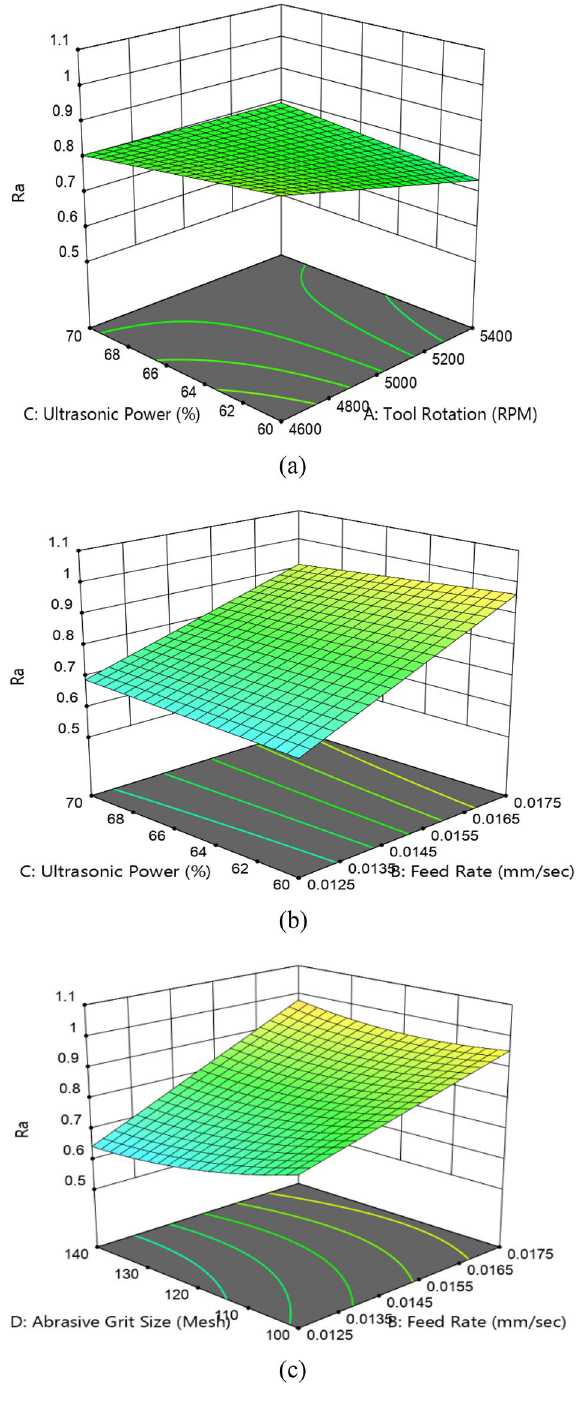
Figure 12. 3D- interaction plot effect R a ( a ) tool rotation and ultrasonic power, ( b ) feed rate and ultrasonic power, and ( c ) feed rate and diamond abrasive